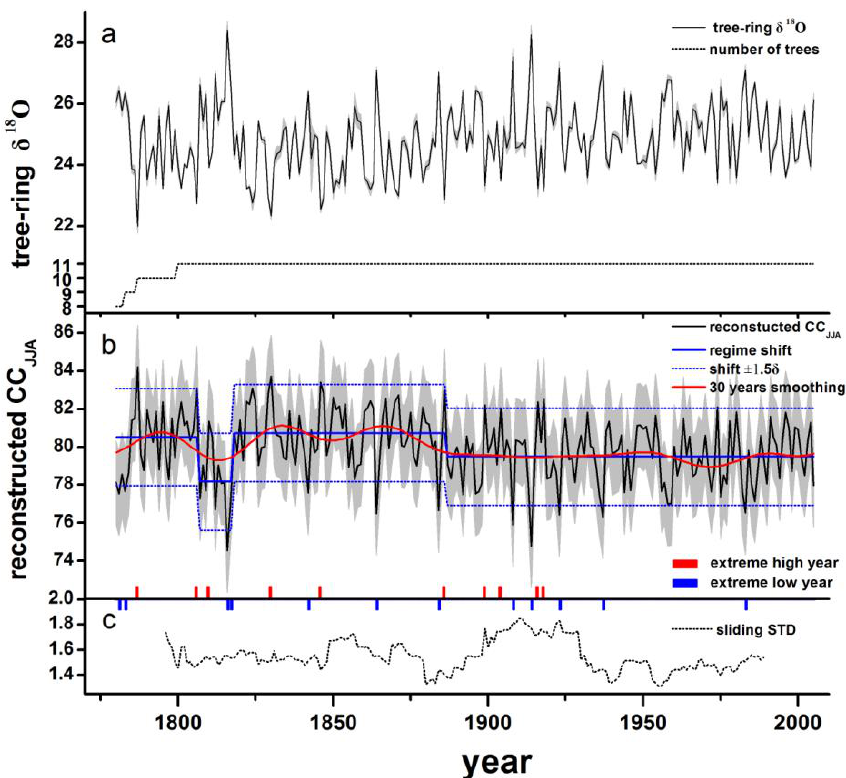
Figure 2: Panel a: Tree-ring δ 18 O with measurement uncertainty (grey shading) and 524 Fig. 2. Panel (a) : tree-ring δ 18 O with measurement uncertainty (grey shading) and number of pooled trees. Panel (b) : reconstructed cloud cover (CC) and regime shift. The black line is the reconstructed CC JJA , with its uncertainty depicted in grey shading (1.5 σ) , the solid blue line is the regime shifts (window length =15yr, confident at 95%); the thick red line is 30yr Gaussian low-pass filter of the reconstructed number of pooled trees. Panel b: Reconstructed cloud cover (CC) and regime shift. 525 CC JJA ; the red and blue bars correspond to extreme high/low cloud cover years (exceeding 1.5 standard deviations at the base of regime). Panel (c) : 31yr moving standard deviation (STD) of the CC JJA residual (calculated as the difference between the reconstructed CC JJA and its mean baseline, shown by the solid blue line in panel b ).